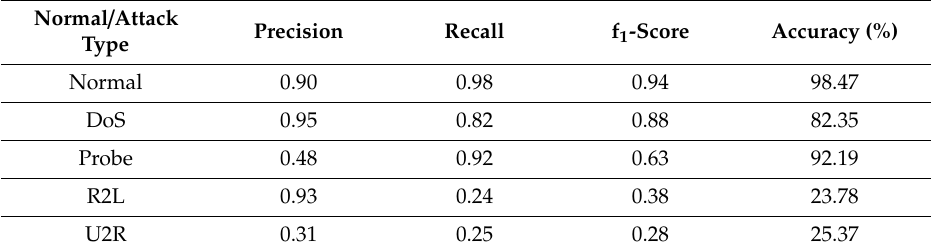
Table 16. Results of the evaluation metrics for multi-class classification using 122 features and 60 neurons in the hidden layers.